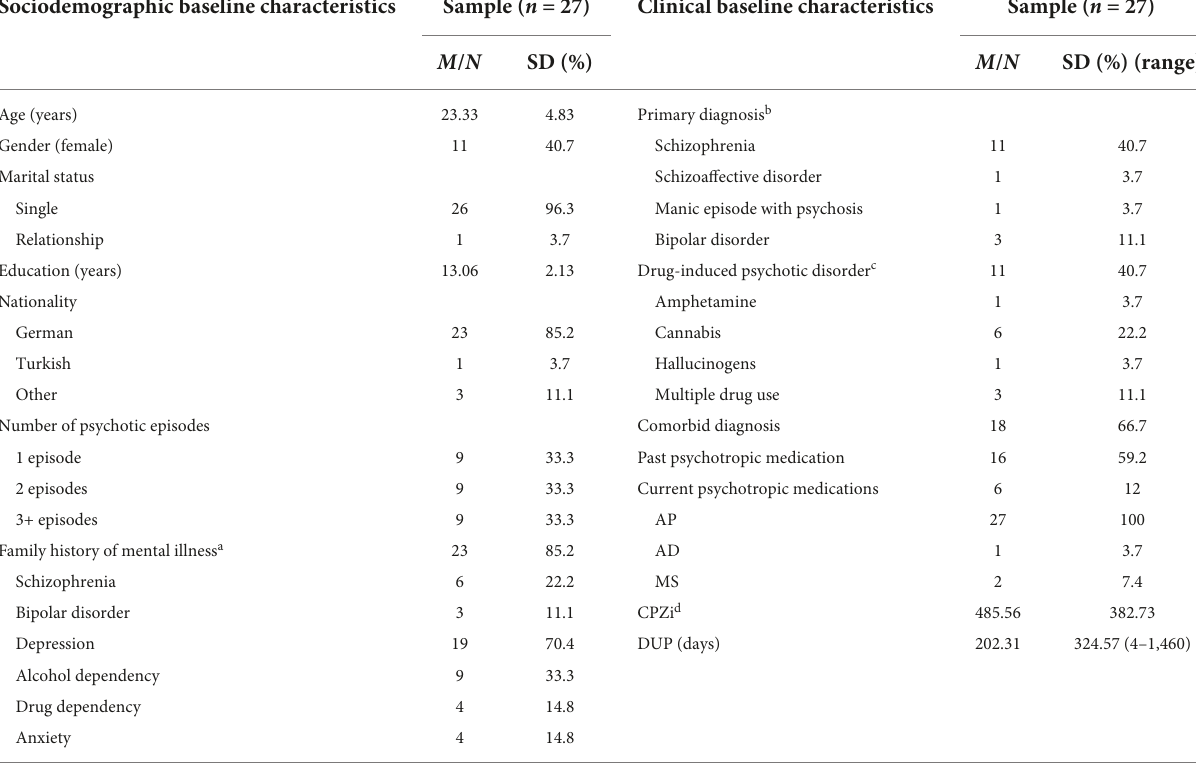
TABLE 1 Sociodemographic and clinical characteristics of participants at baseline. Sociodemographic baseline characteristics